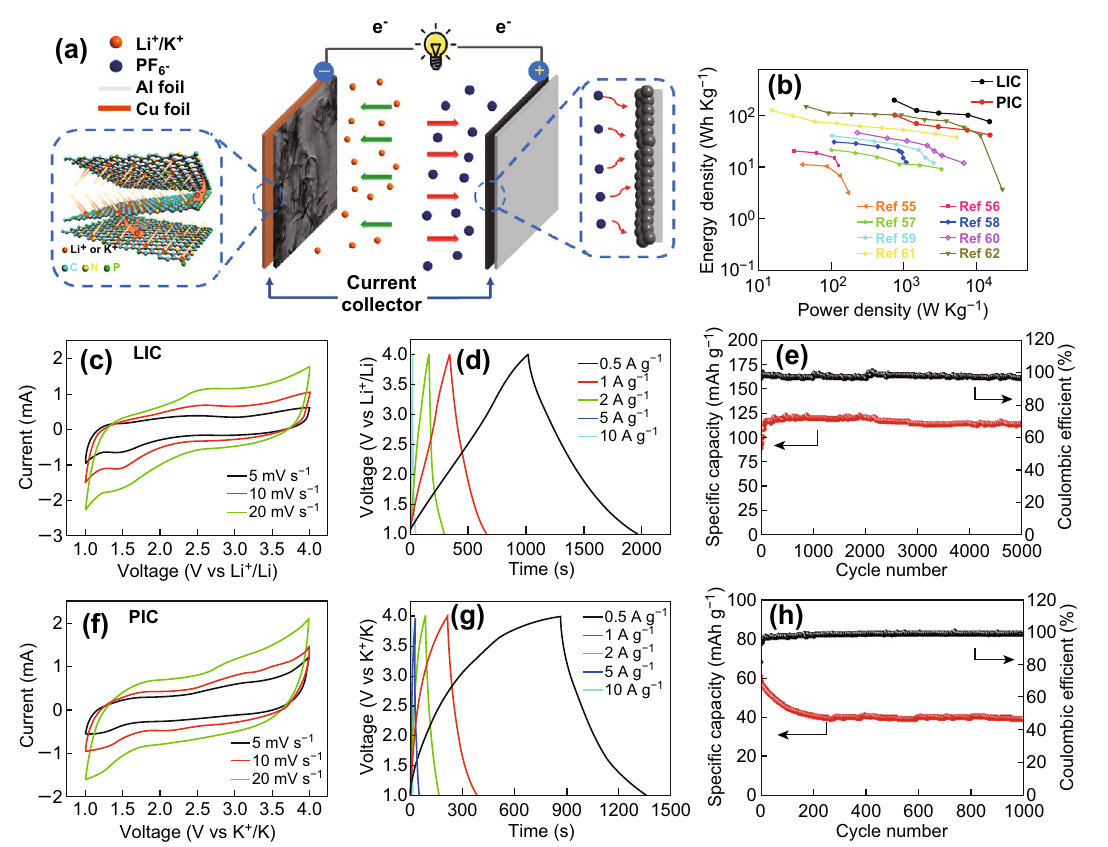
Fig. 7 a Schematic illustration of the working mechanism. b Ragone plots compared with literature values at the optimal cathode/anode mass ratio of 6:1. c , f CV curves at scan rates of 5, 10, and 20 mV s −1 . d , g Galvanostatic charge–discharge curves at current densities of 0.5–10 A g −1 . e , h Cycling stability over 5000 and 1000 cycles at a current density of 1 A g